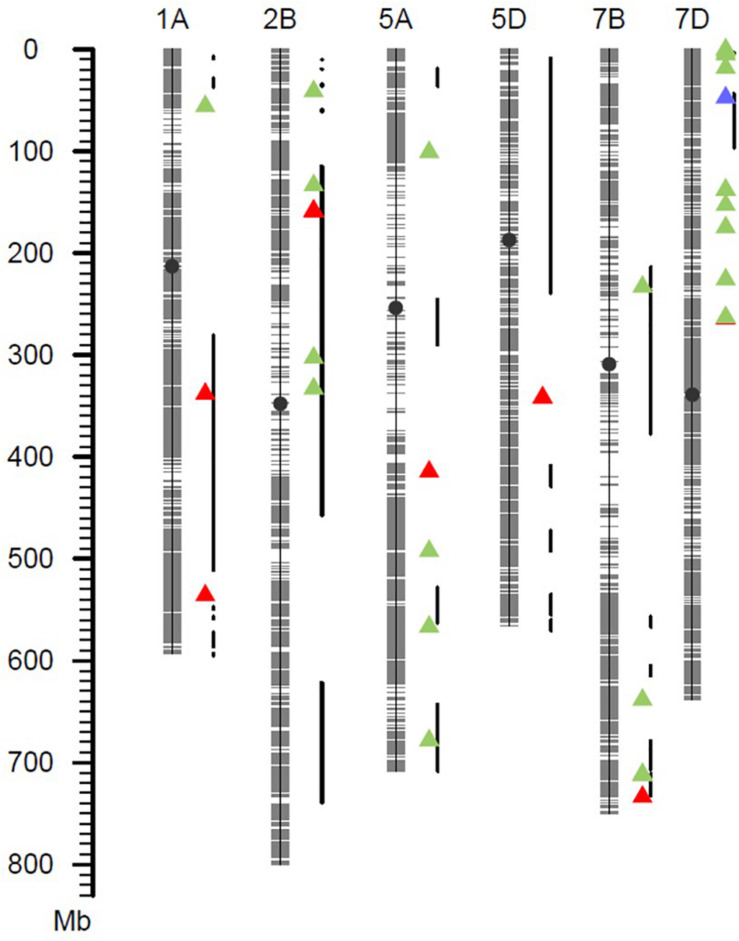
Exhibition of high-confidence QTLs and previously reported QTLs. Red triangles represented QTLs detected in this study. Green triangles represented QTLs detected in Chinese wheat landraces. Blue triangle represented Yr18. The thick black lines represented QTLs reported in the literature.